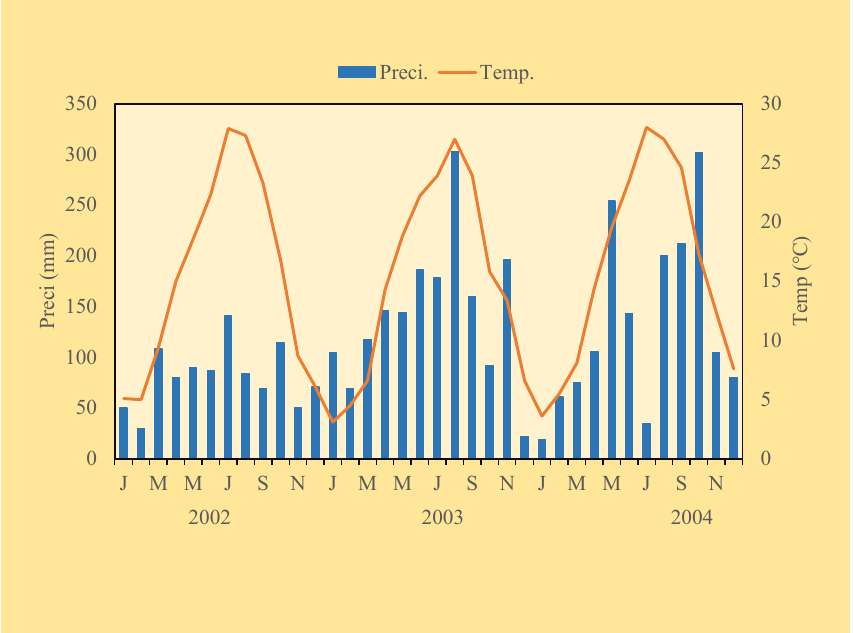
Figure 2. Monthly mean air temperature and monthly total precipitation from January 2002 to December 2004 at Kyotanabe automated weather station. The data used in this paper were from July 2002 to March